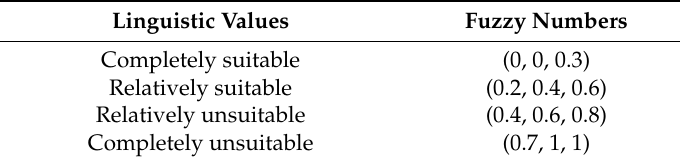
Table 4. Linguistic values and their corresponding fuzzy numbers of